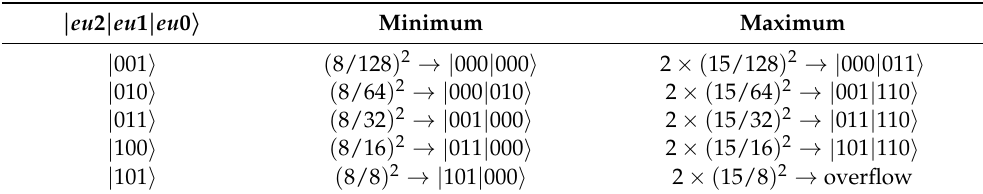
Table 1. Setting u 2 + v 2 as floating-point numbers. For different exponents of u -velocity, the range of numbers is shown. The exponent bias is